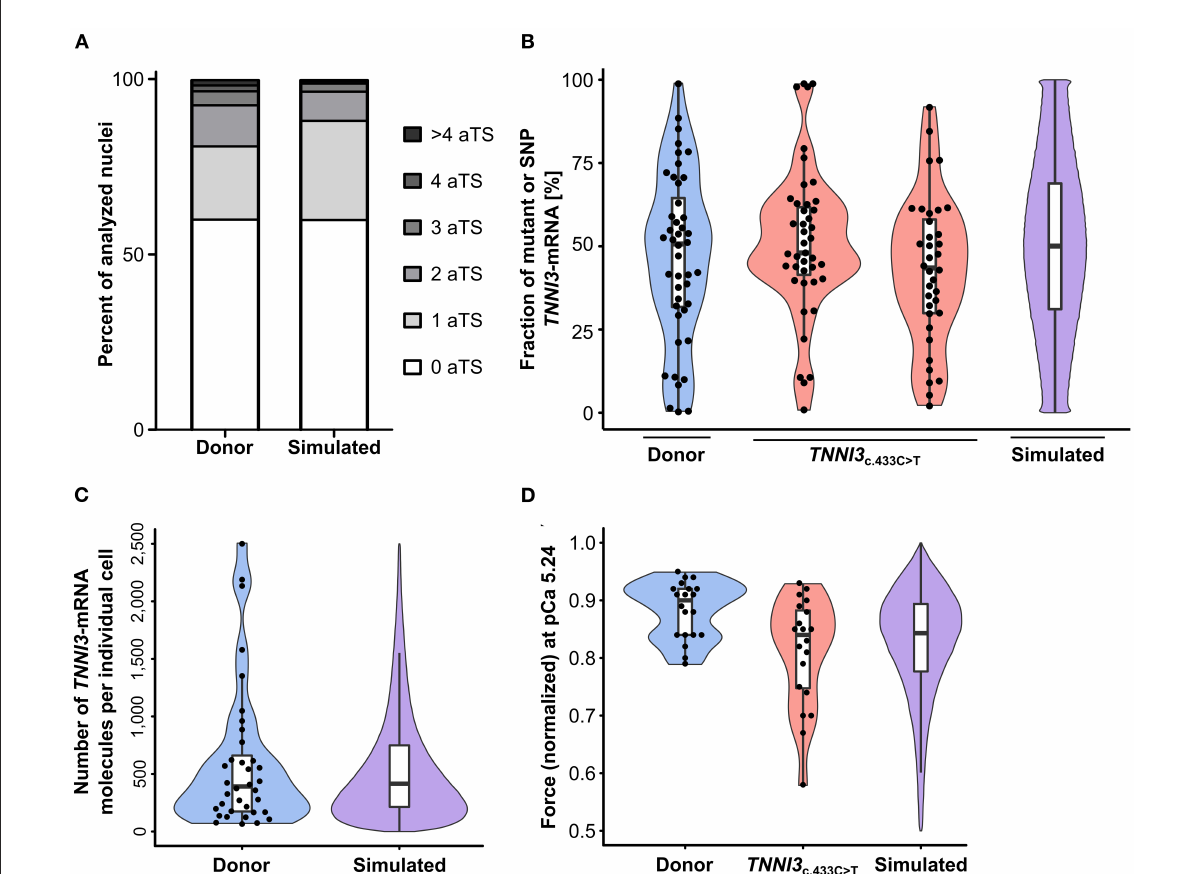
FIGURE5 Experimental results from donor and from patients with TNNI3 -mutations in comparison to simulation results from the model. (A) TNNI3 -aTS distribution from three donors (H89, H108, and H113) compared to aTS distribution simulated by model. Percentage of nuclei with 0, 1, 2, 3, 4, and > 4 aTS was plotted. (B) Percentage of TNNI3- SNP-allele transcripts from a donor and of TNNI3- mutant-allele transcripts from two cTnI R145W patients (densitometric analysis of allele-specific restriction fragments), compared to the simulated distribution. Each data point represents the mean of replicates from one cell. Violin plots represent probability density of experimental data (blue and red) and probability density simulated by model (violet). Horizontal bar, median; white rectangle, interquartile range. (C) Total TNNI3 -mRNA counts in donor cardiomyocytes. Violin plot probability density of the data (blue) compared to outcome of model simulation (violet). (D) Force values of individual cardiomyocytes for donor and for TNNI3 c.433C > T patient at pCa 5.24, normalized to respective maximum force, compared to simulation outcome. Dots represent individual cardiomyocytes. Violin plots, probability density of data (blue and red) and of model simulation